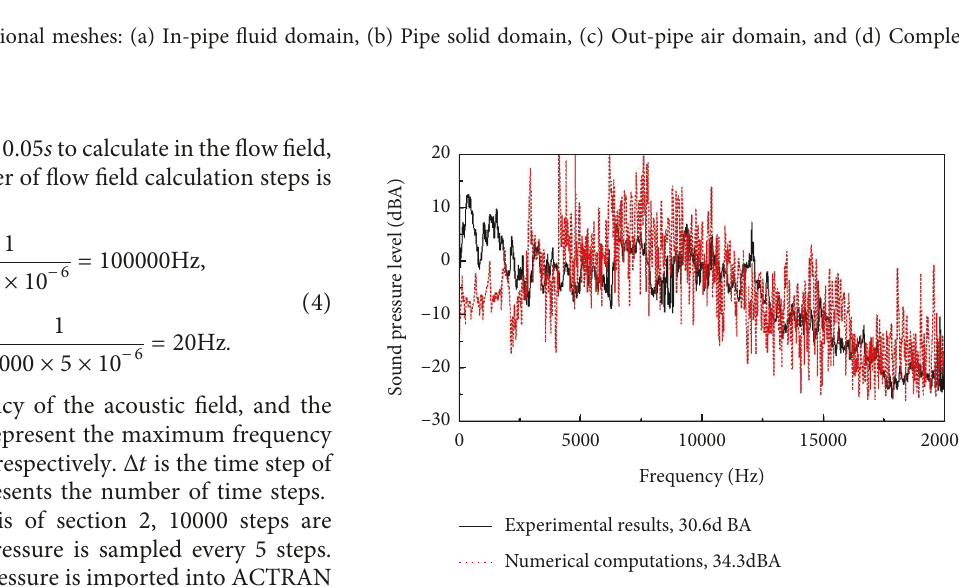
Figure 5: Spectral contrast diagram of